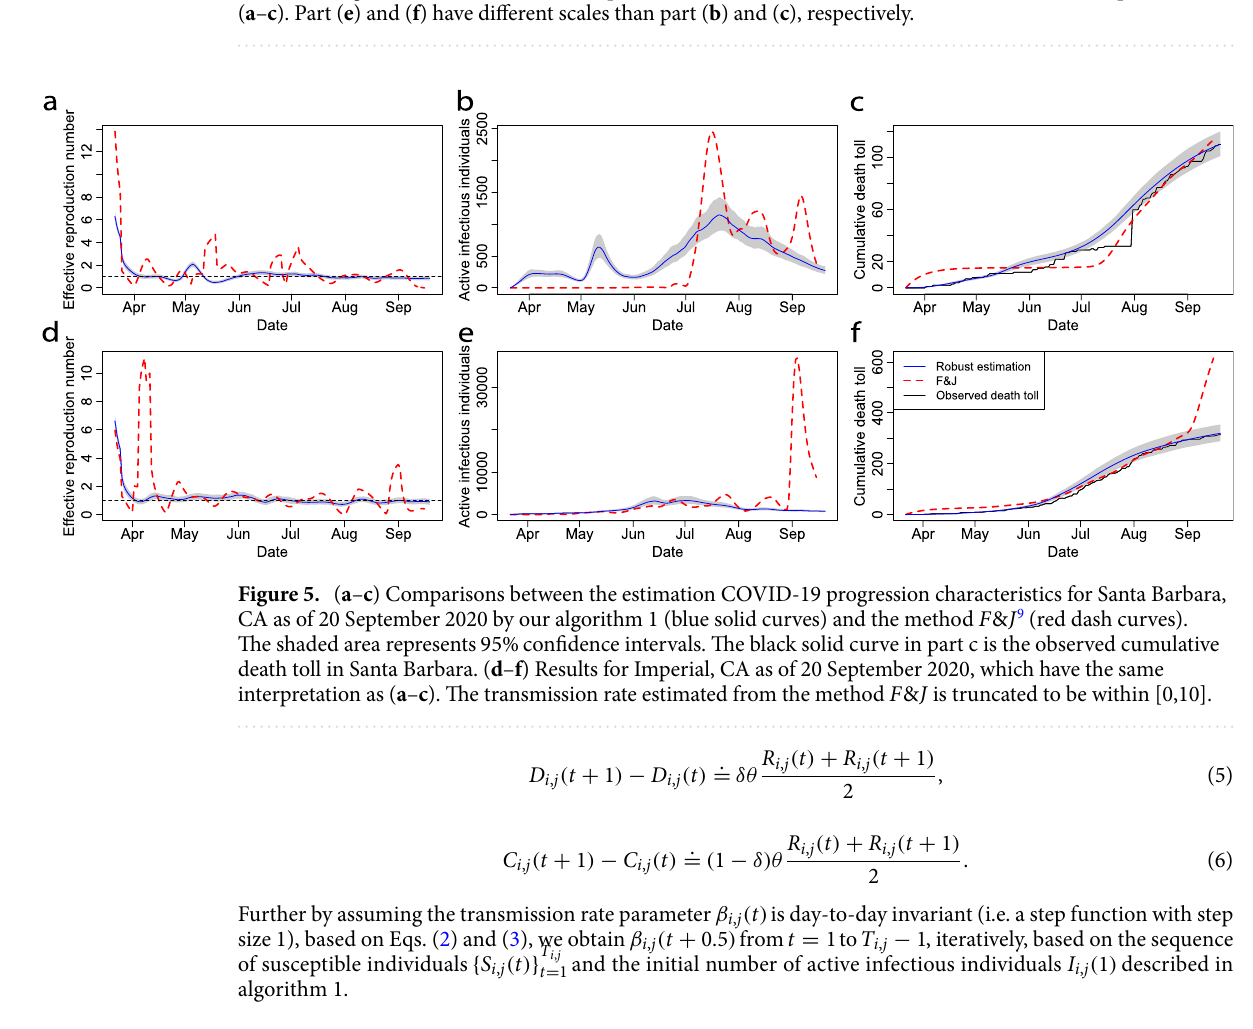
Figure 4. ( a ) The estimated probability of contracting SARS-CoV-2 in Washington state on 20 September 2020. ( b ) the probability of contracting SARS-CoV-2 from 5 counties in Washington state with the largest PoC SARS- CoV-2 values on 20 September 2020 . ( c ) the observed (dots) and fitted (solid line) cumulative death toll in the 5 counties in figure ( b ) from the same time period. ( d – f ) The results in Texas that have the same interpretation as ( a – c ). Part ( e ) and ( f ) have different scales than part ( b ) and ( c ), respectively.